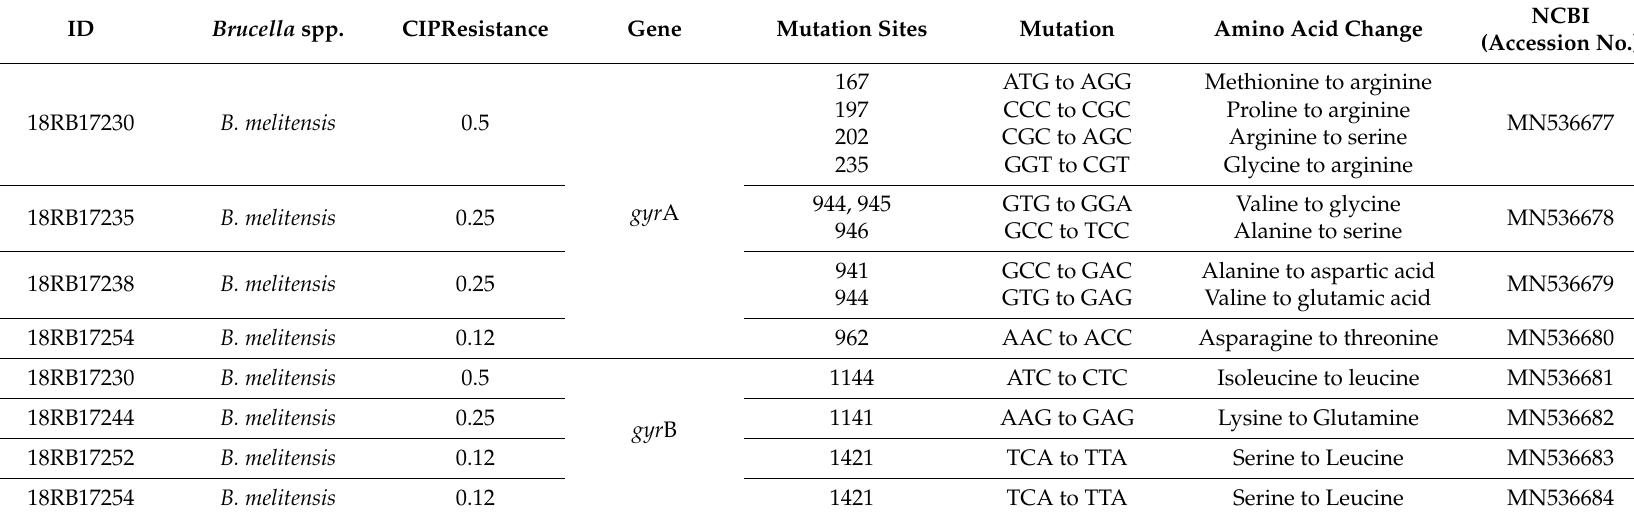
Table 4. Detection of mutations in gyr A and gyr B genes associated with ciprofloxacin resistance in B.